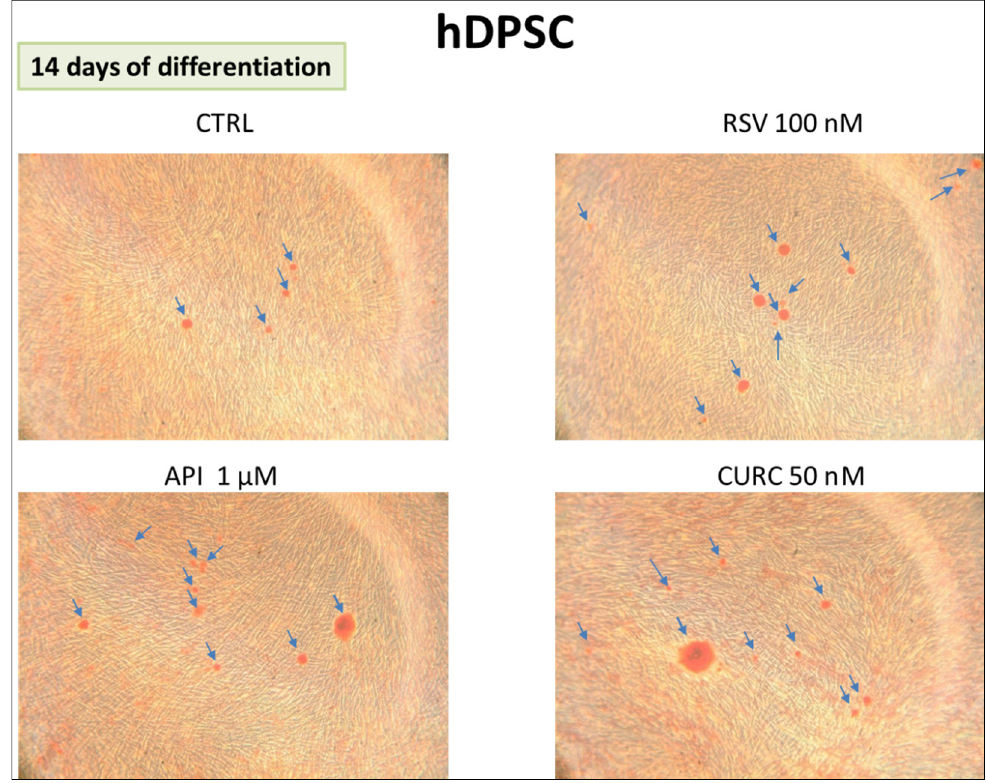
Figure 3. Alizarin Red assay on hDPSC cultures at 14 days of differentiation. The arrows indicate the calcification nodules formation (magnification 10×).